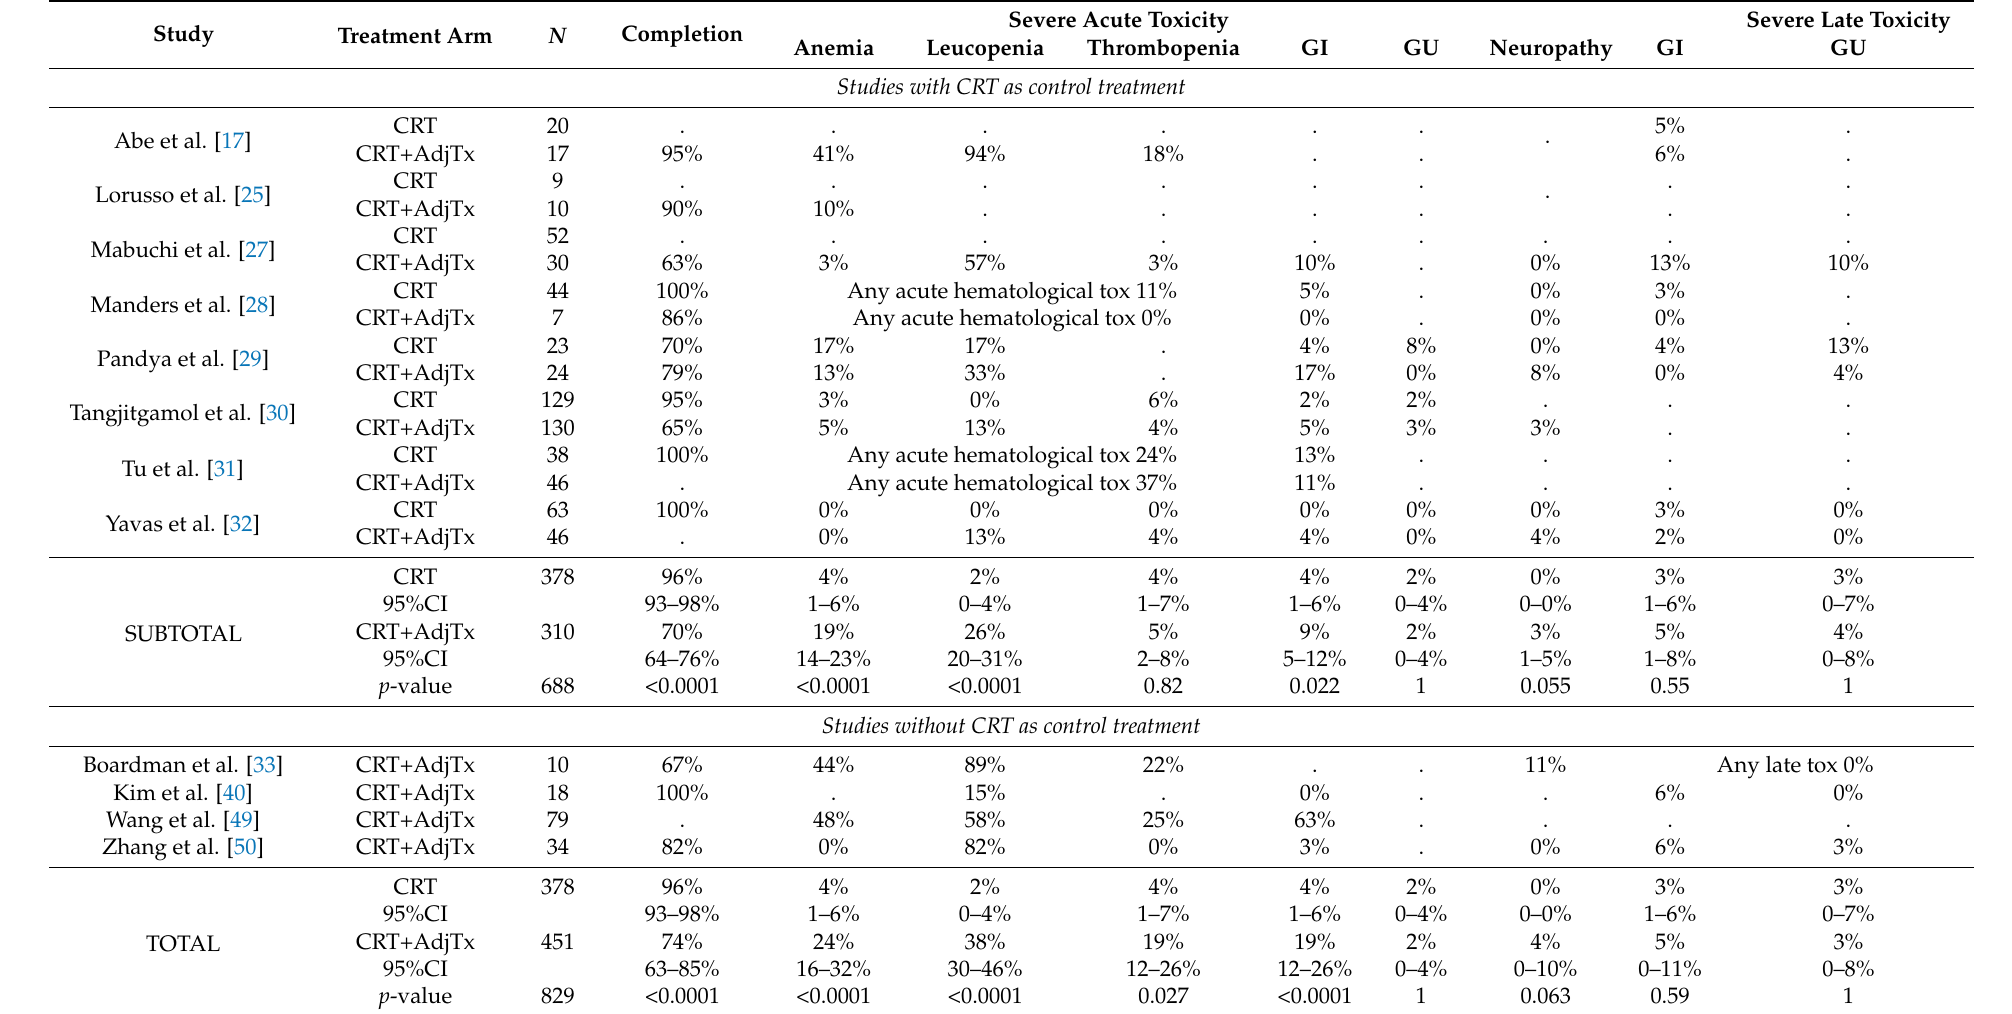
Table 4. Feasibility and toxicity adjuvant platinum derivate and